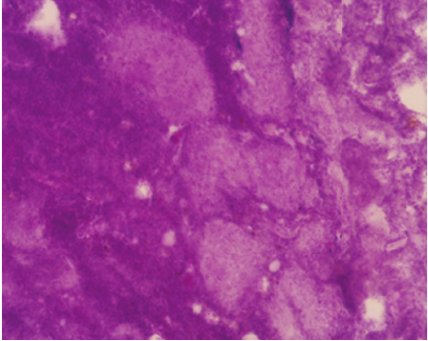
Figure 4: PAS stain 40x. Internal bacteria stained with the PAS